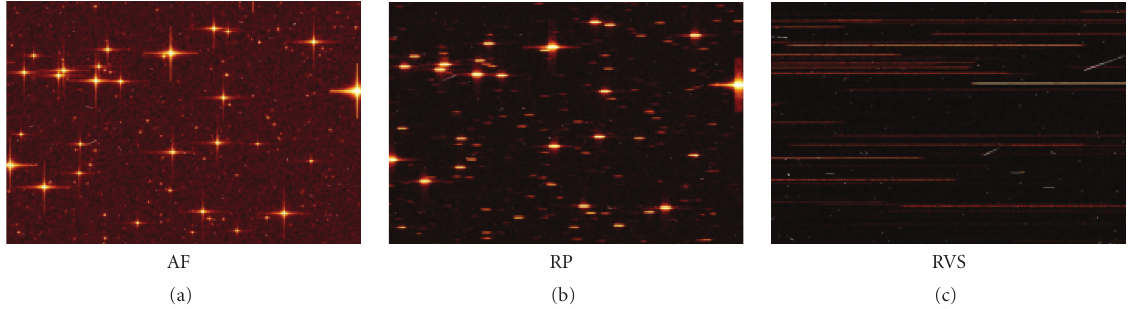
Figure 3: Three observation modes of Gaia : AF = astrometric, RP = photometric, RVS = spectrophotometric [5].